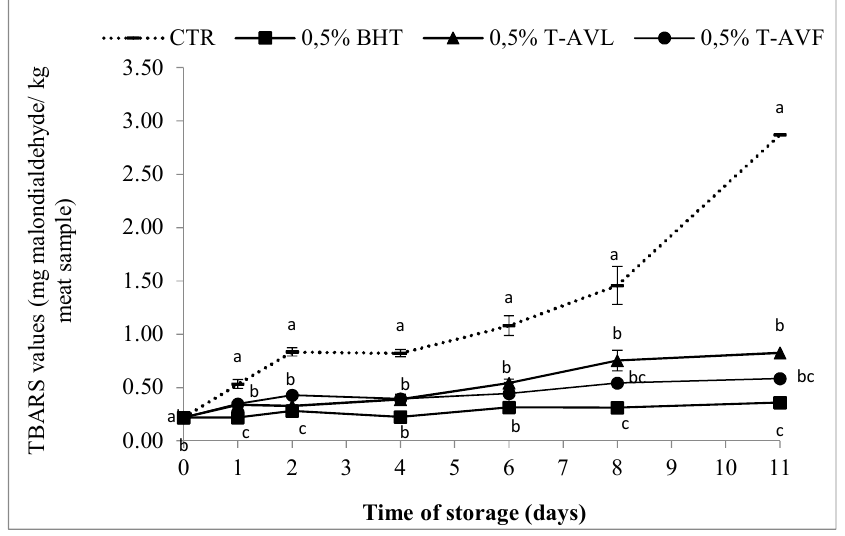
Figure 4. Thiobarbituric Acid Reactive Substance (TBARS) values of raw beef patties formulated with powdered leaves and flowers of A. vulneraria during storage at 4 ± 1 °C. CTR (Control sample without antioxidant), 0.5% BHT (treatment with 0.5% synthetic antioxidant (Butylated hydroxytoluene)), 0.5% T-AVL (treatment with 0.5% A. vulneraria leaf), 0.5% T-AVF (treatment with 0.5% A. vulneraria flower). Results represent the mean of three replicates ( n = 3) and are expressed as mean value ± SD; different letters in the same day indicate significant difference between samples at p < 0.05.